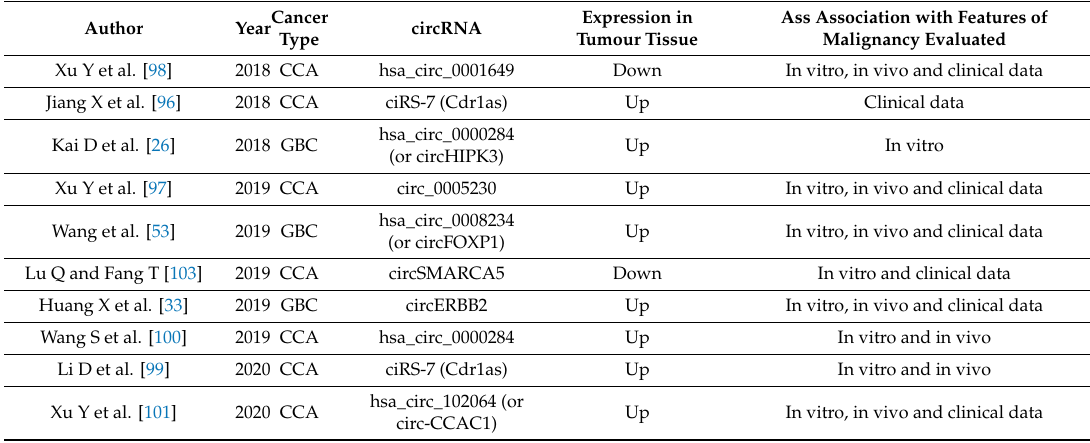
Table 6. Summary of di ff erentially expressed circRNAs investigated in biliary tract